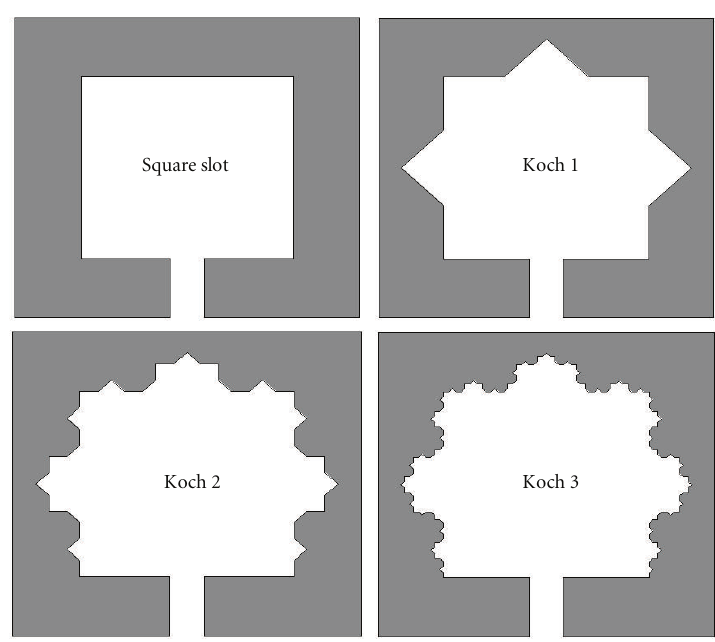
Figure 2: Geometries of the square slot and the Koch island for di ff erent